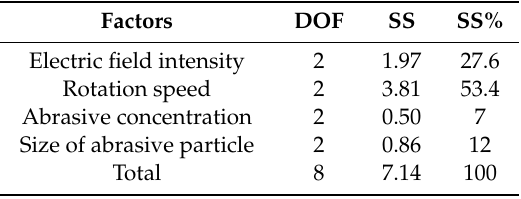
Table 7. ANOVA of MRR.